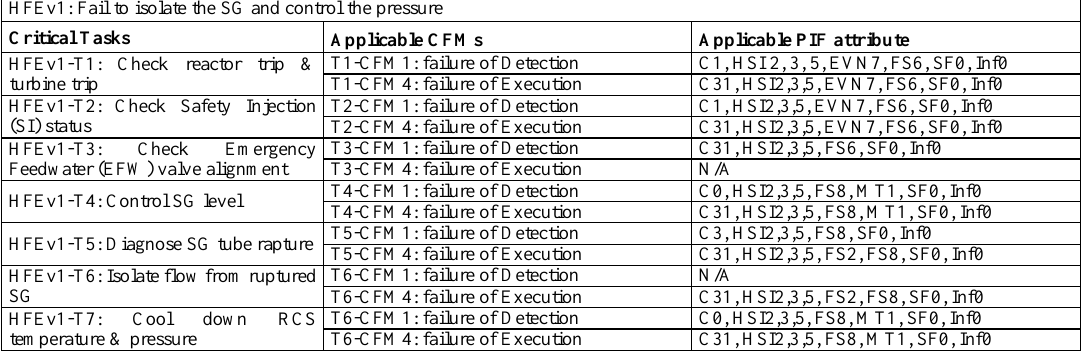
Table 3. Summary of CFMs/PIFs in critical